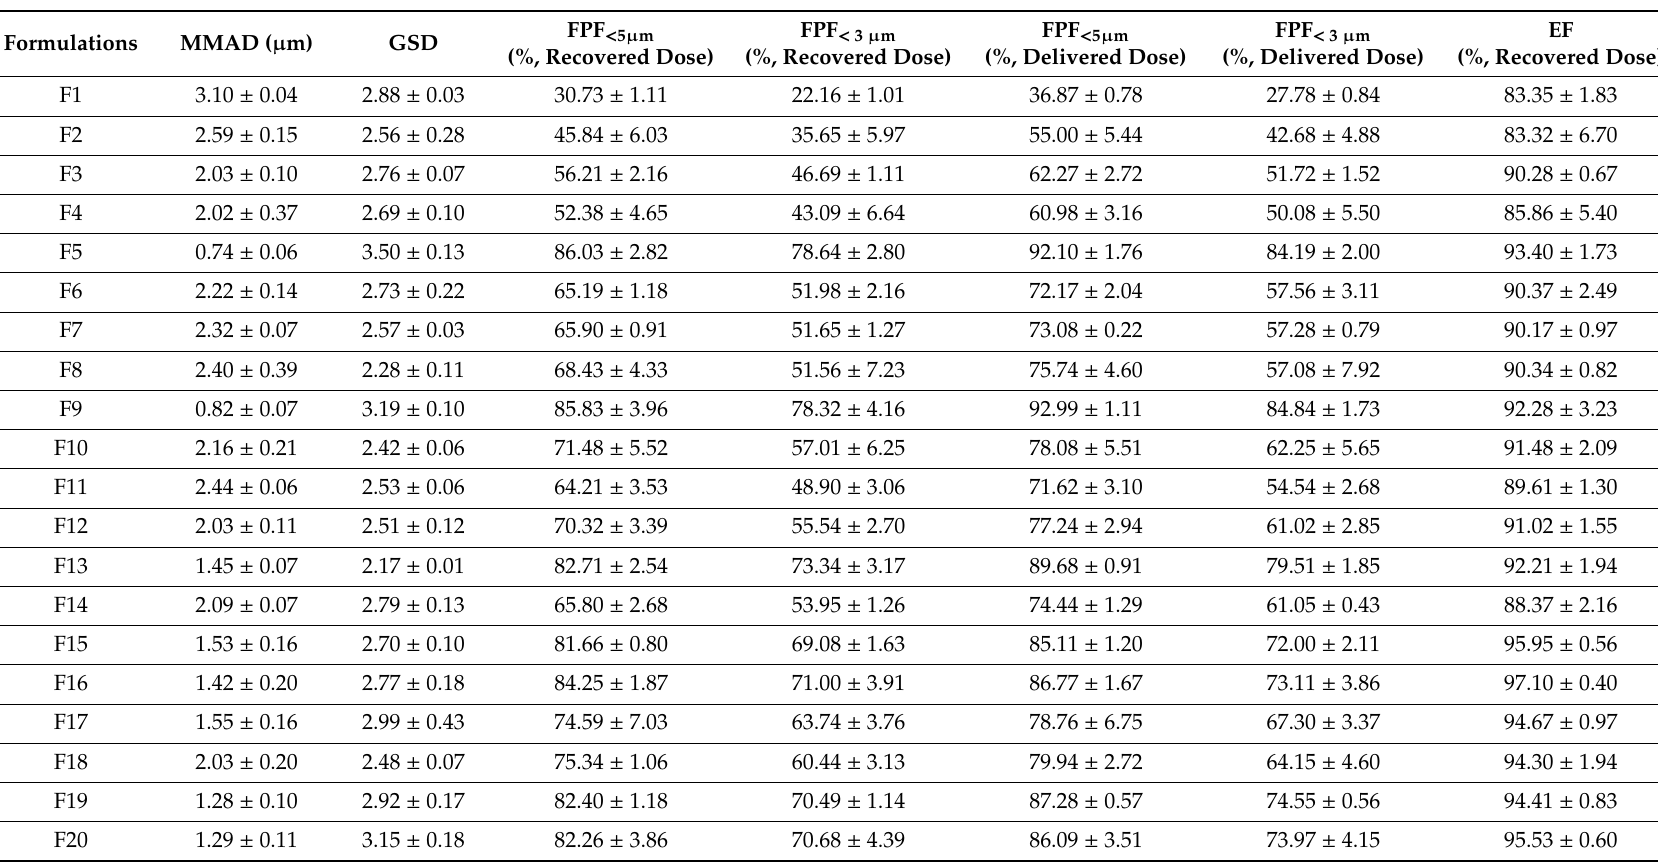
Table 2. Aerosol performance of TFF remdesivir powders using a Plastiape ® RS00 high-resistance DPI at a flow rate of 60 L / min ( n = 3). (MMAD, mass median aerodynamic diameter; GSD, geometric standard deviation; FPF, fine particle fraction; EF, emitted fraction).